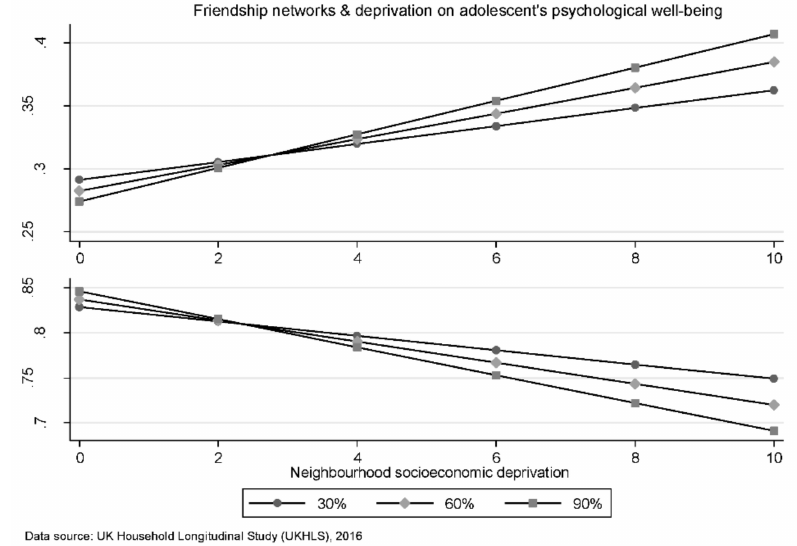
Figure 2. Estimated marginal mean e ff ects (at representative values) of neighbourhood deprivation and friendship network on psychological well-being. X-axis higher numbers indicate greater socioeconomic deprivation, on the y-axis higher numbers indicate life satisfaction and mental health, and the lines represent the marginal e ff ects at various levels of friendship networks (i.e., 30%, 60%, and 90%) within a given neighbourhood. Scales